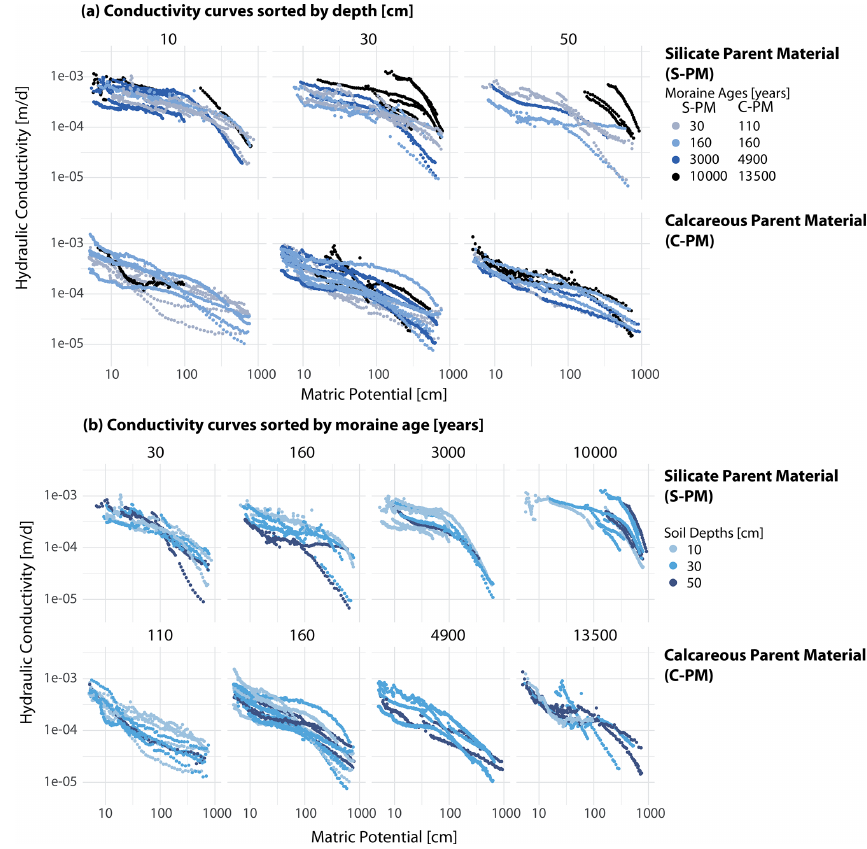
Figure 8. Development of hydraulic conductivity curves at 10, 30, and 50cm over 10 millennia on silicate (S-PM) and calcareous (C-PM) parent material sorted by depth (a) and moraine age (b)